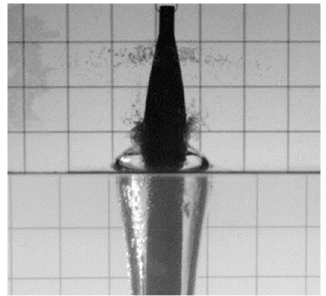
Figure 18. The partial splash map of the hydrophobic model at the initial velocity v = 3.95 m/s.